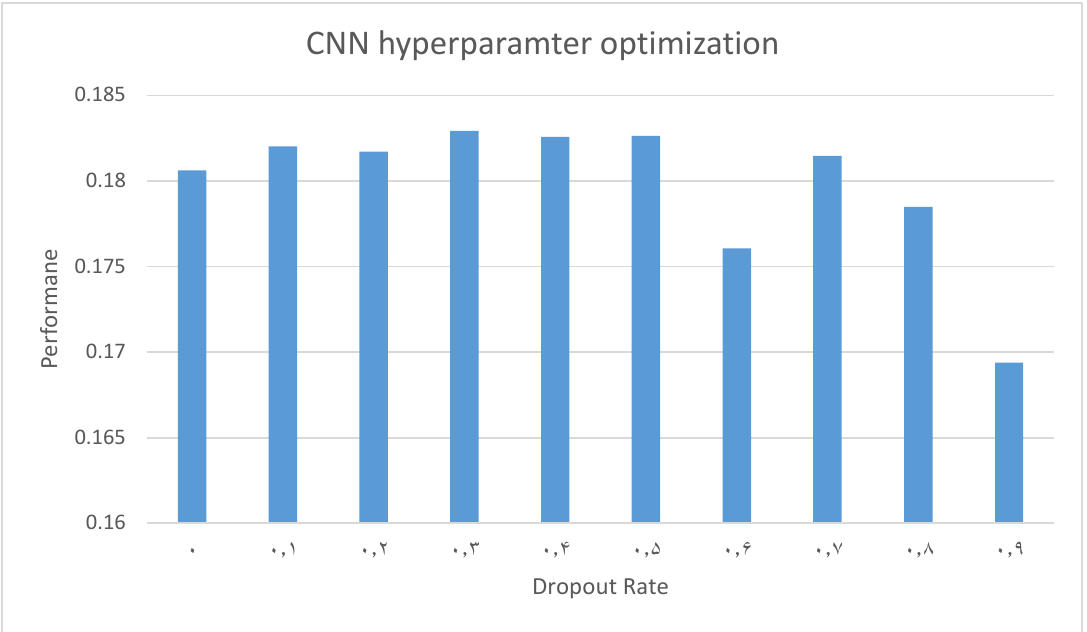
Figure A-6 Optimized Dropout Rate of CNN